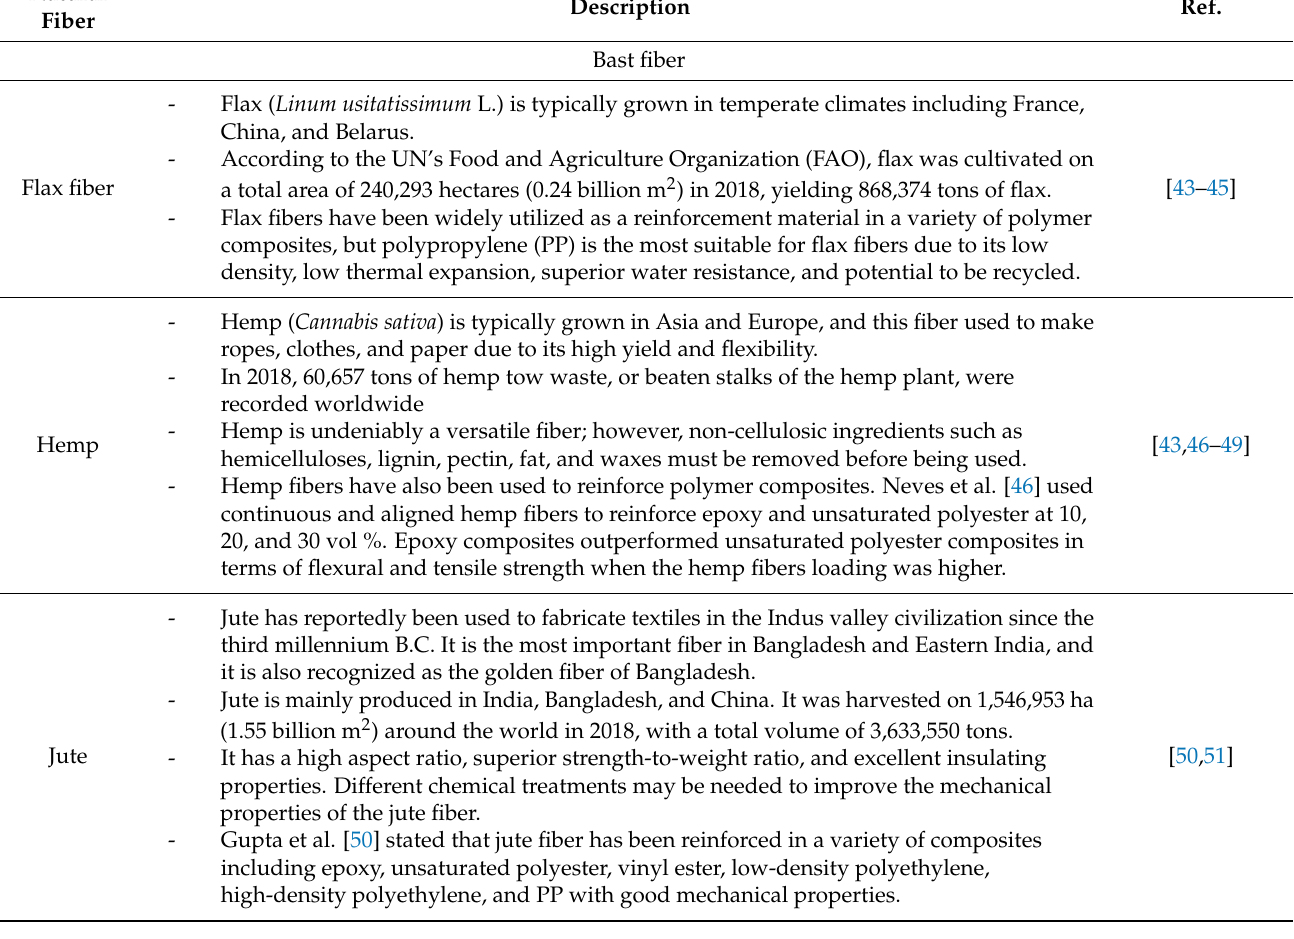
Table 3. Summary of natural fibers characteristics and applications in polymer composites. Natural